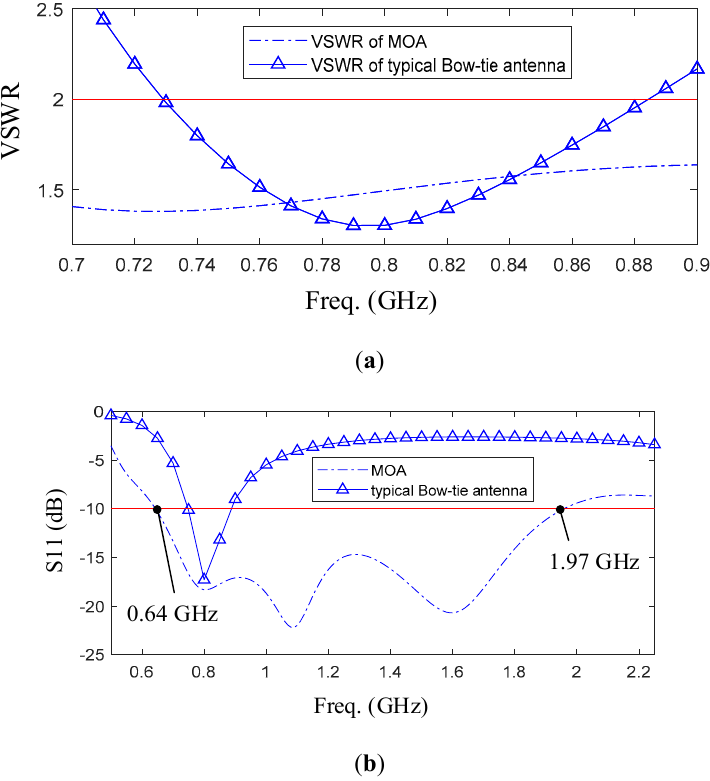
Figure 8. ( a ) Simulated VSWR for typical Bow-tie antenna and modified antenna; ( b ) The reflection coefficient of modified antenna.